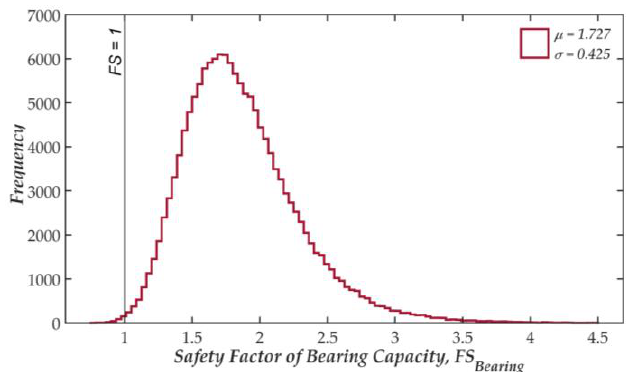
Figure 13. Histogram of the bearing capacity safety factor of foundation (Gamcheon BRW).